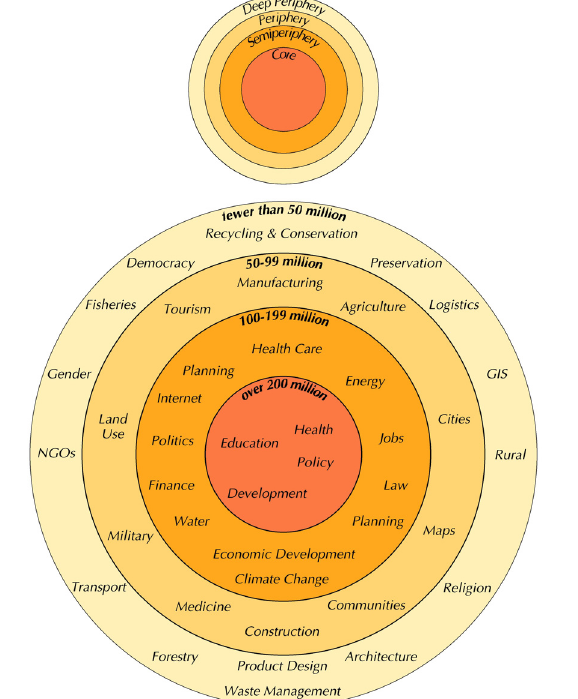
Figure1. Mapping Sustainability Hyperlinks from Google